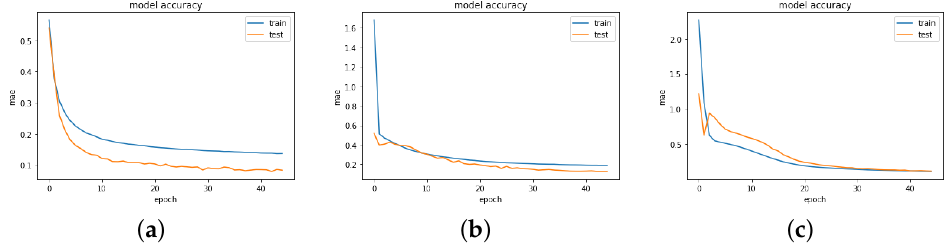
Figure 3. Train/Test MAE values for Models B1, B2 and B3; ( a ) MAE—Model B1; ( b ) MAE—Model B2; ( c ) MAE—Model B3.